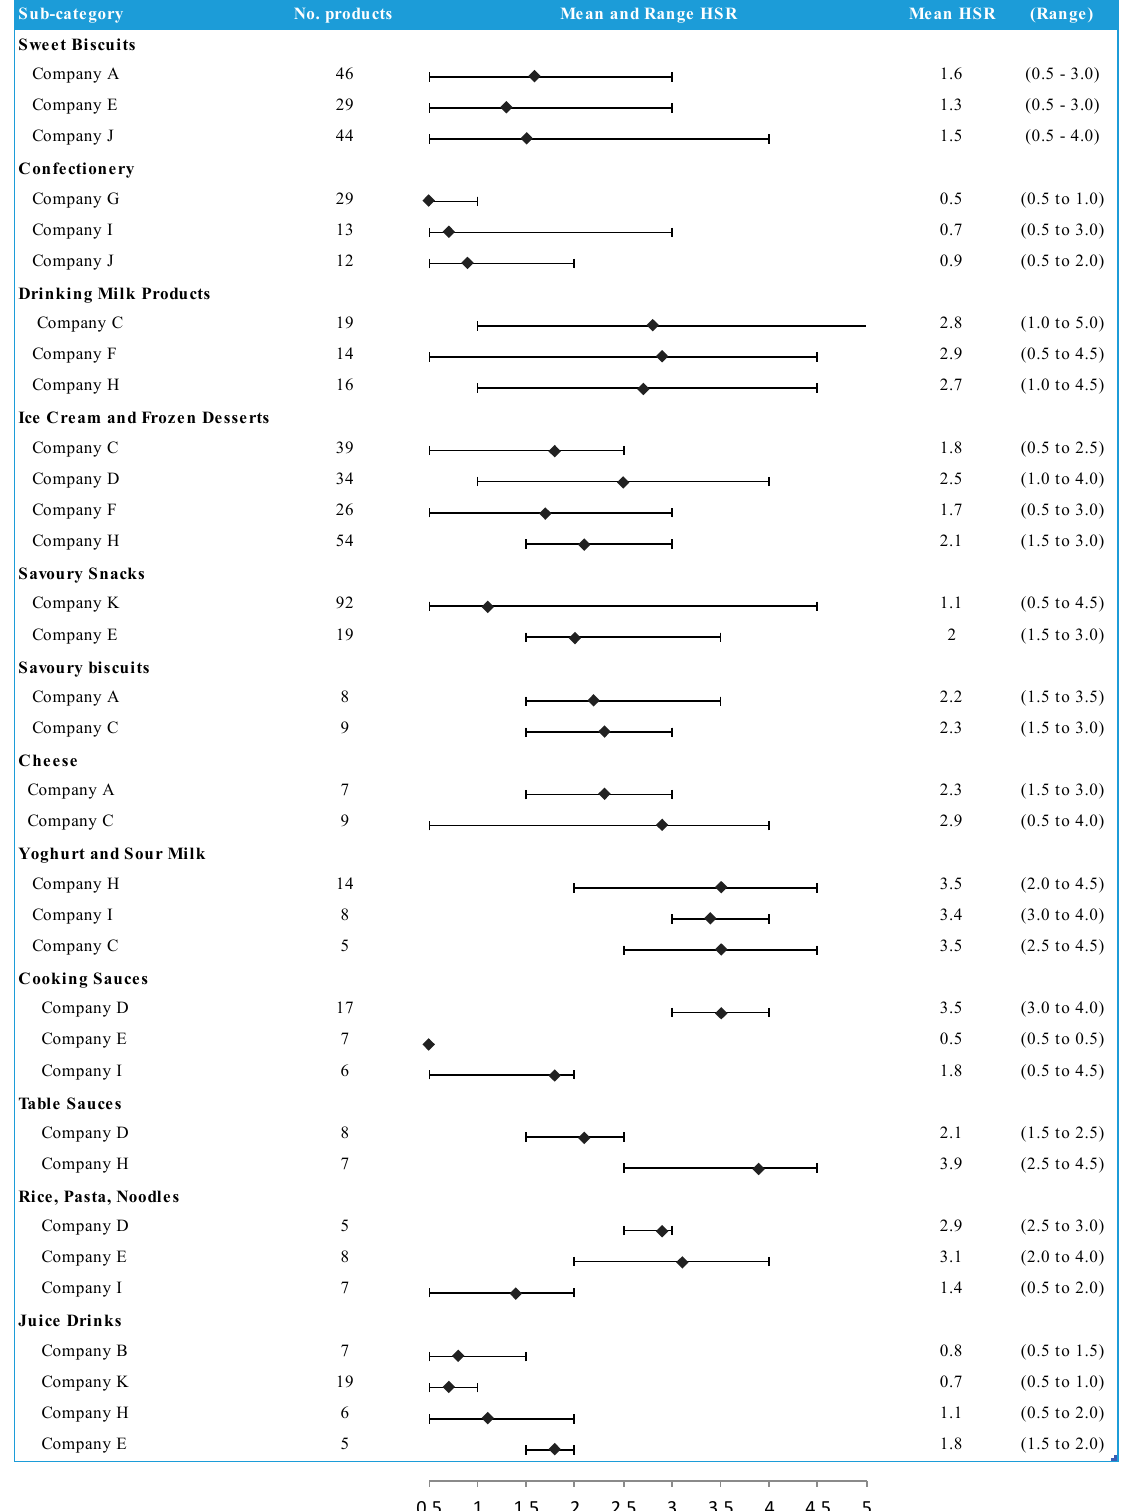
Figure 4. Figure 3 Mean and range HSR by company for selected Euromonitor subsets.